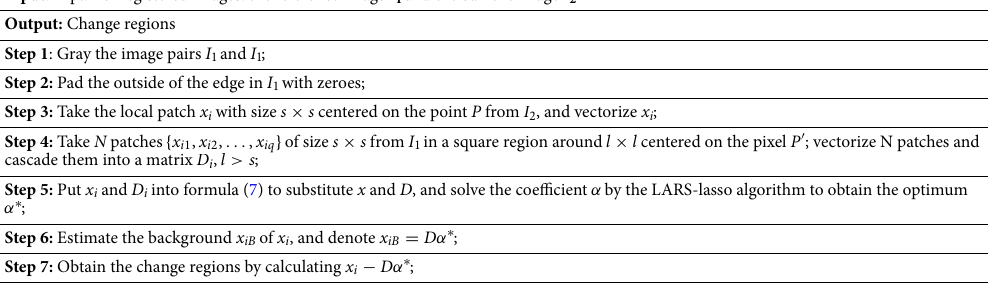
Table 2. SRC change detection algorithm proposed in this